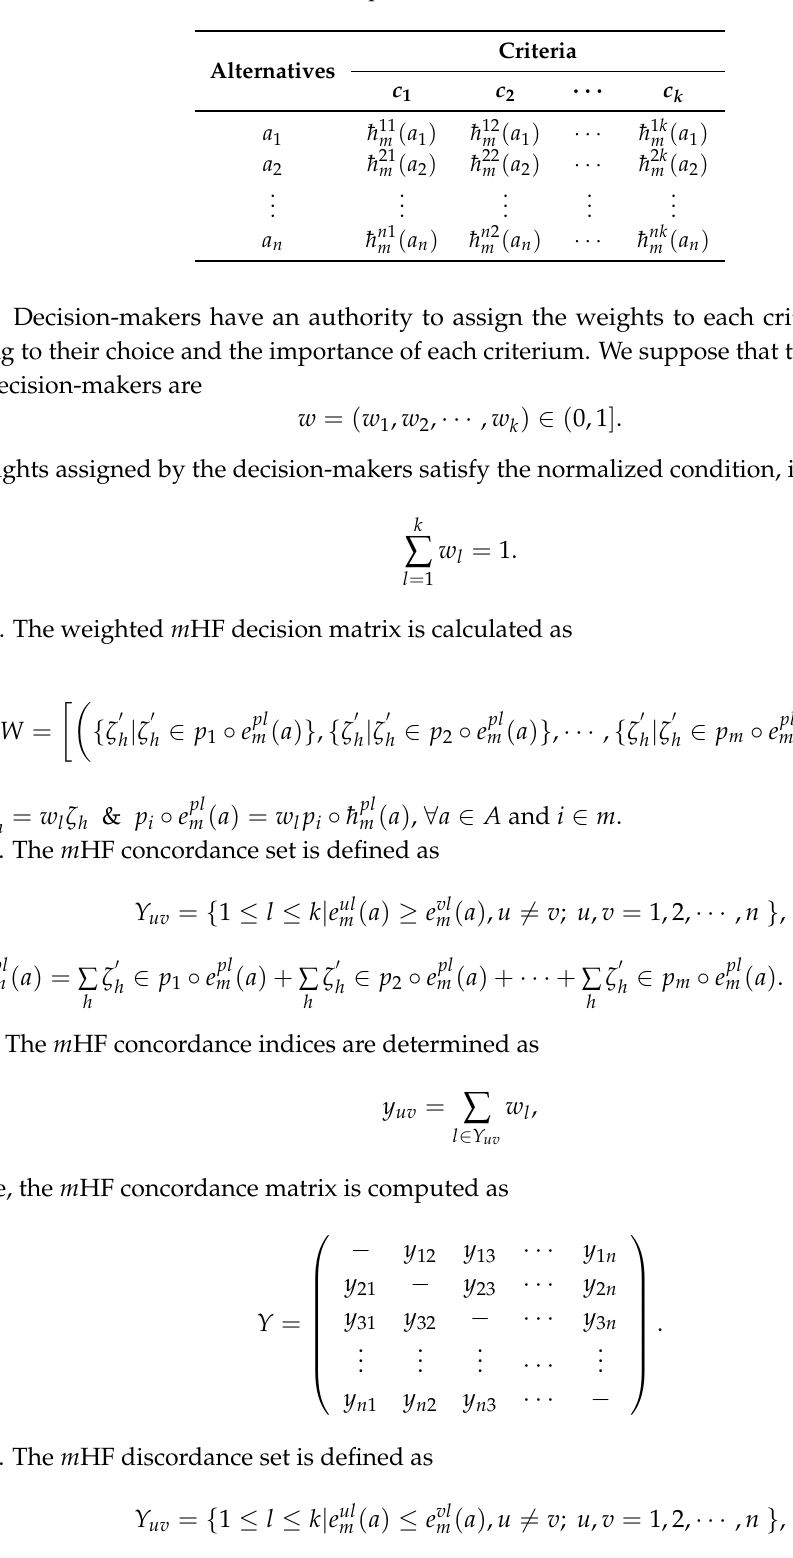
Table 1. Tabular representation of m HF decision